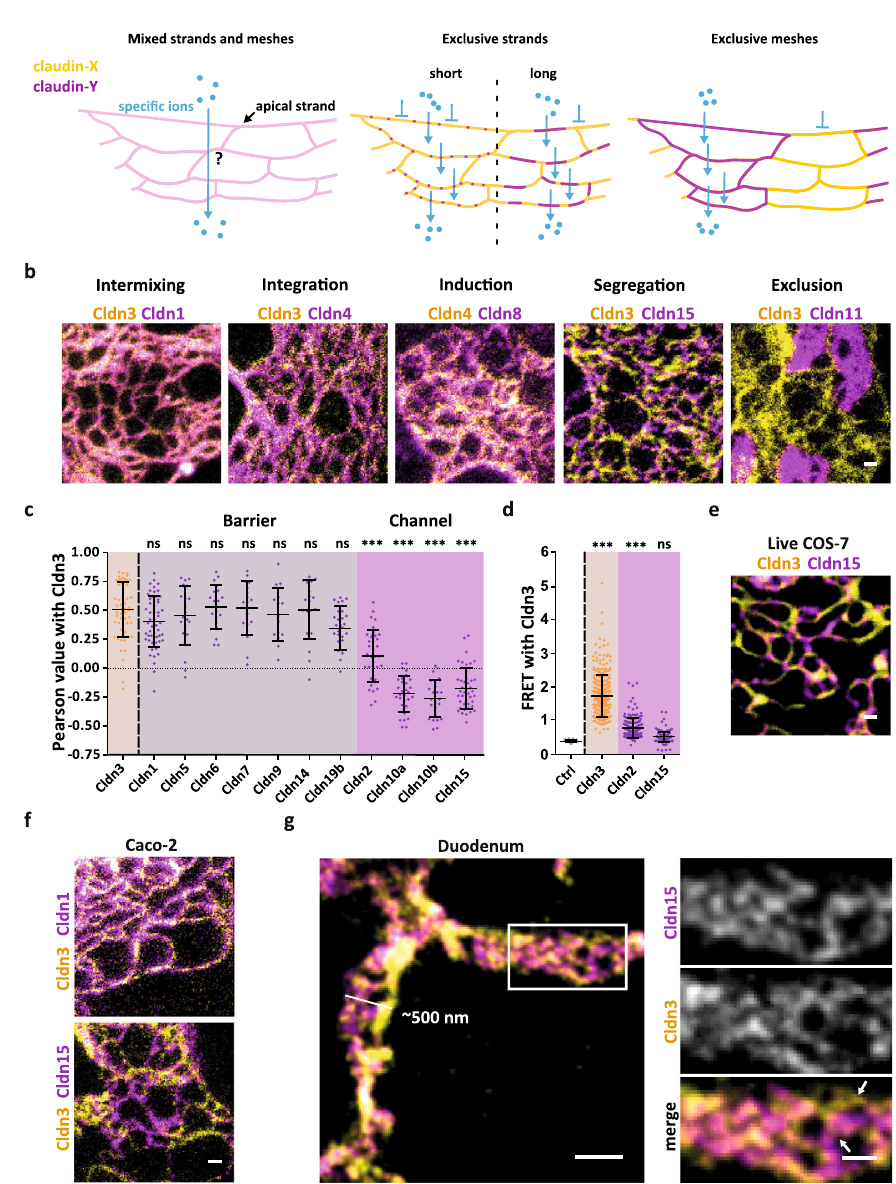
Fig. 3 | Claudins form characteristic copolymers including segregation of channel-formingclaudinsfromCldn3.a Schemeisillustratingpredictedclaudin- claudin organization patterns. Two claudins (yellow and magenta) that are com- patible with each other tightly colocalize in the TJ (pink). Incompatible claudins separateintodifferentstrandsorevenlargerclaudin-speci fi cparts.Thisseparation might facilitate permeability of speci fi c ions (cyan) over the TJ meshwork. b Representative STED images of TJ-like meshwork of the observed fi ve organiza- tionpatternsformedbytheindicatedco-expressedclaudins(SNAP-tagged(yellow; BG-Atto590) and YFP-tagged (magenta; α -GFP-NB-Atto647N)) in fi xed COS-7 cells areshown.Tightcolocalization:intermixingofmesh-formingclaudins,integration of non-mesh-forming with a mesh-forming claudin or induction (de novo mesh- forming of co-expressed non-mesh-forming claudins). Separated claudins: segre- gation and exclusion. c Pearson correlation analysis of Cldn3 co-expressed with barrier-forming (gray) or channel-forming (magenta) claudins. Co-expression of Cldn3withCldn3(yellow)servedaspositivecontrol.Datarepresentthemean±SD. Every n represents the Pearson of one TJ-like meshwork. n (Cldn3+Cldn3)=55; n (Cldn3+Cldn1)=54; n (Cldn3+Cldn5)=20; n (Cldn3+Cldn6)=20; n (Cldn3+ Cldn7)=17; n (Cldn3+Cldn9)=15; n (Cldn3+Cldn14)=19; n (Cldn3+Cldn19b)=25; n (Cldn3+Cldn2)=36; n (Cldn3+Cldn10a)=30; n (Cldn3+Cldn10b)=24; n (Cldn3+Cldn15)=42; from 3 – 6 independent experiments; one-way ANOVA with